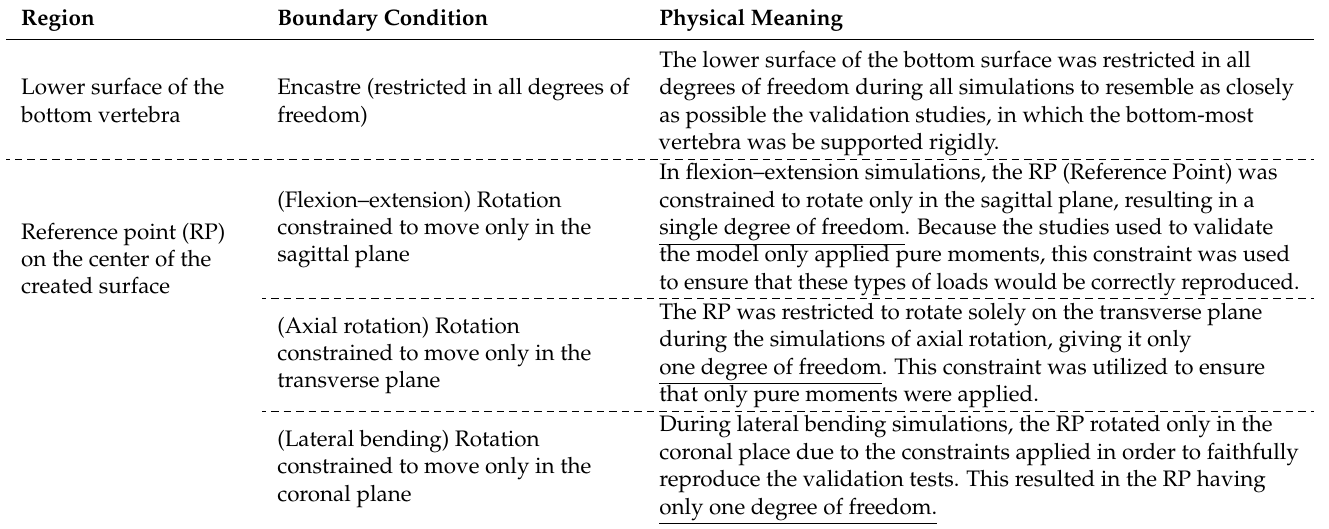
Table 2. Boundary conditions and their explanation for the various